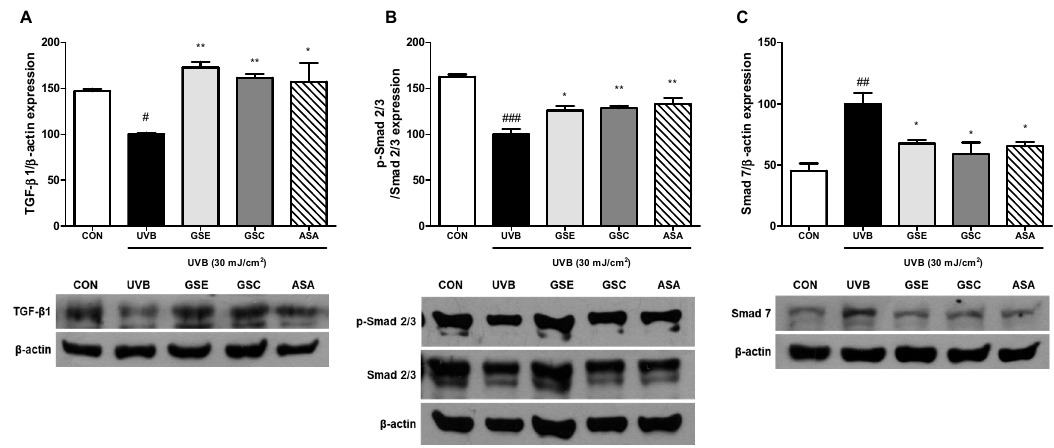
Figure 5. Effects of ginseng seed embryo (GSE) and coat (GSC) on transforming growth factor- β (TGF- β ) level and phosphorylation of Smad. Control or UVB-irradiated cells were treated with/without GSE or GSC and subjected to western blotting for ( A ) TGF- β , ( B ) p-Smad 2/3, and ( C ) Smad 7 levels. The relative levels of the phosphorylated protein were normalized to those of β -actin or total Smad 2/3 proteins. Values are expressed as the mean ± standard error ( n = 3). #, ##, and ### p < 0.05, 0.01, and 0.001, significant difference compared to control; * and ** p < 0.05 and 0.01, respectively, significant difference compared to UVB-irradiated group. ASA (ascorbic acid, 100 μ M), positive control.